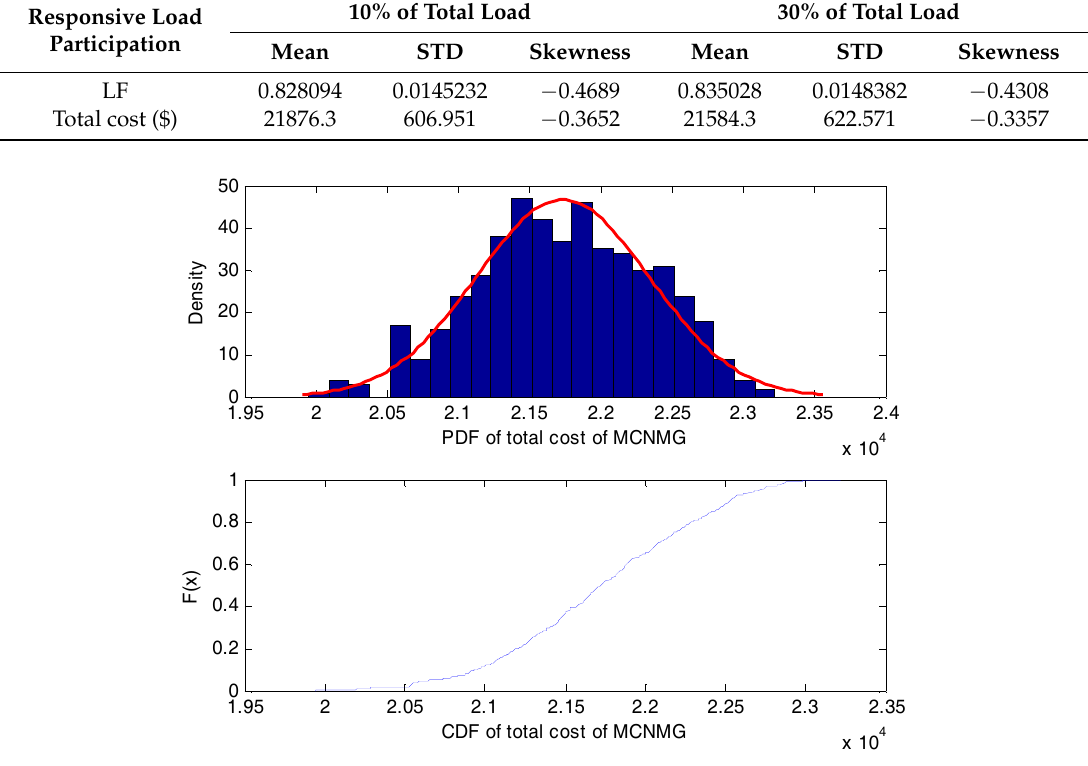
Figure. 14. Total cost of MCNMG. Top: PDF; Bottom: CDF. Figure 14. Total cost of MCNMG. Top: PDF; Bottom: